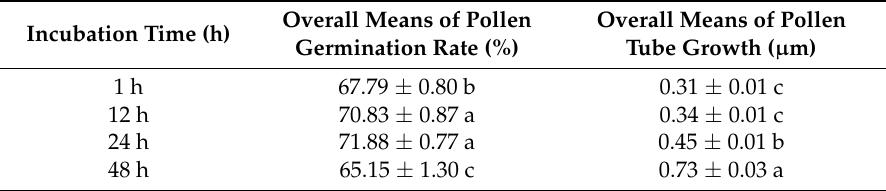
Table 9. Effect of incubation time on in vitro pollen germination and tube growth.